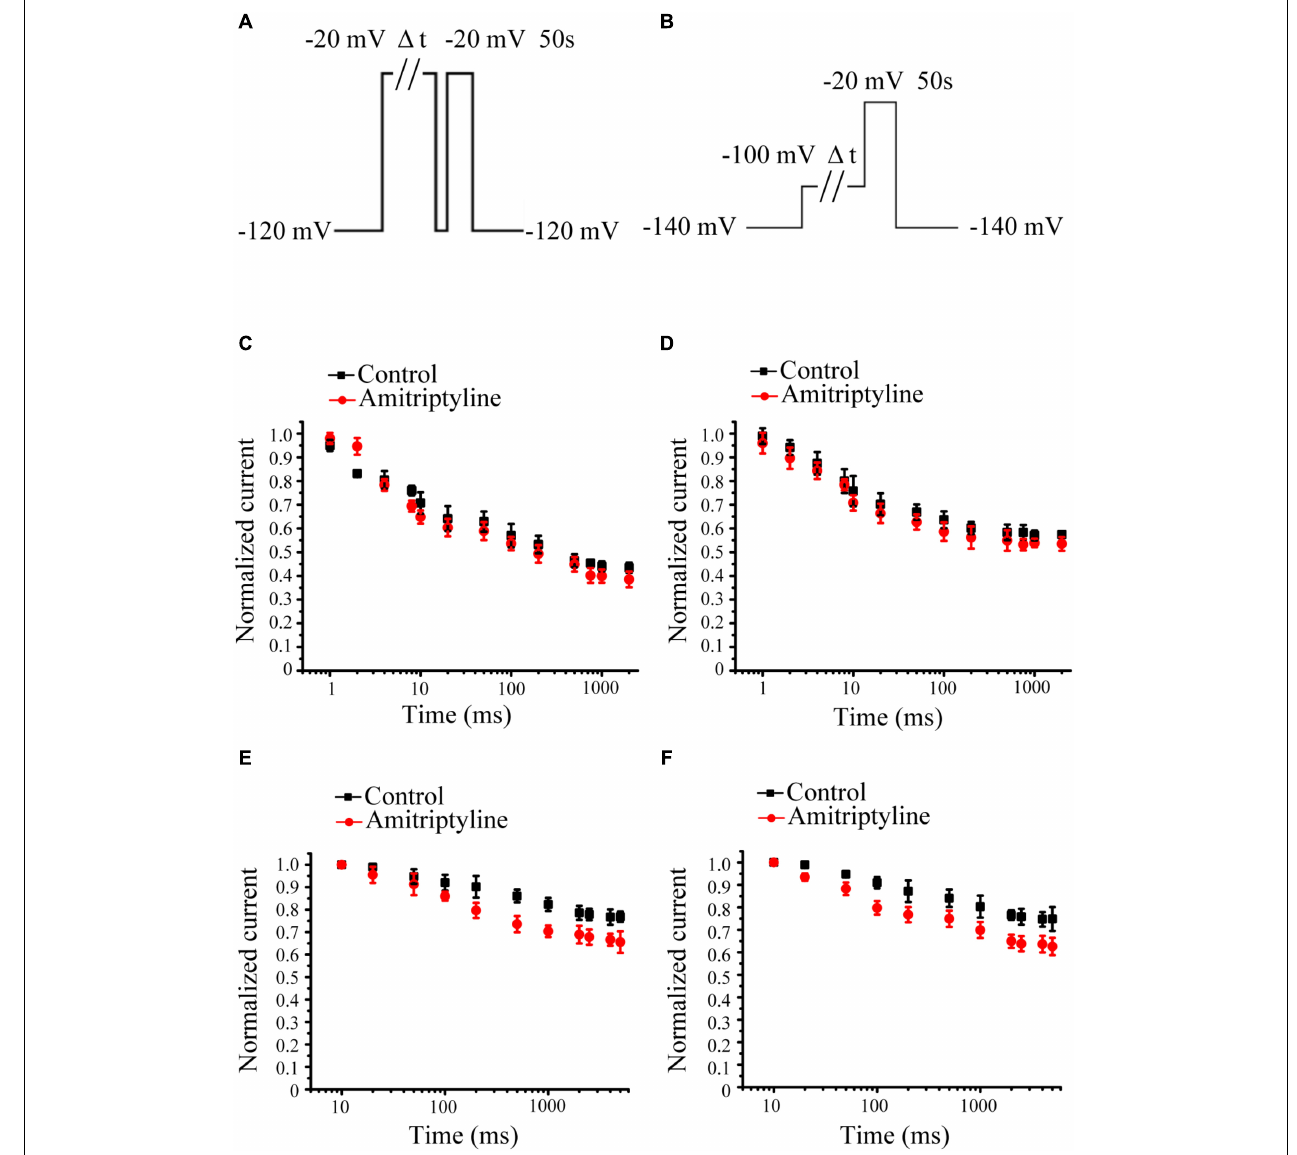
FIGURE 3 | Effect of amitriptyline on intermediate-state inactivation (ISI) and closed-state inactivation (CSI) of Nav1.5 currents. (A) Protocols for ISI recording. (B) Protocols for CSI recording. (C) ISI curves for the acute effect of amitriptyline. (D) ISI cures for the long-term effect of amitriptyline. (E) CSI curves for the acute effect of amitriptyline. (F) CSI cures for the long-term effect of amitriptyline.